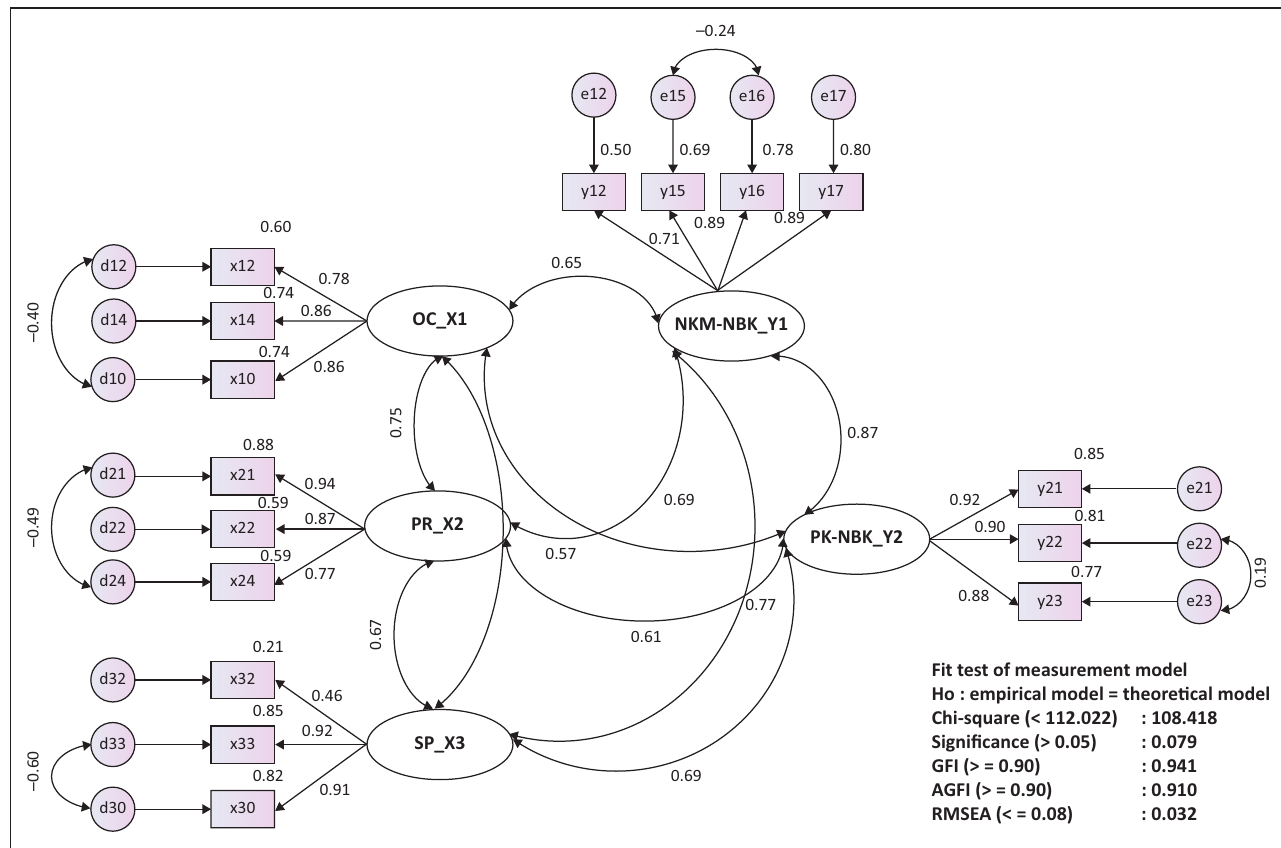
FIGURE 2: Simultaneous concept measurement model.